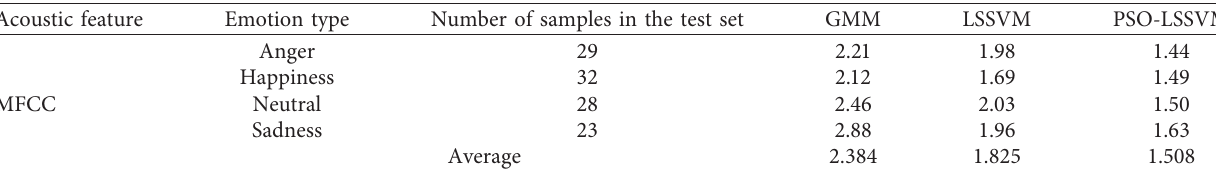
Table 3: Comparison of MMCD in articulatory-to-acoustic conversion based on GMM, LSSVM, and PSO-LSSVM (dB). Acoustic feature